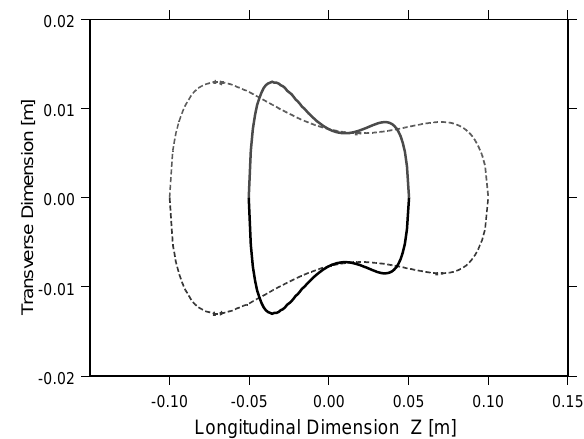
FIG. 10. The compressed beam bunch (solid line) inside a round metal pipe 4 cm in diameter, carrying the same space charge as the beam bunch of Fig. 1 (dashed line). To evaluate the importance of incorporating the ≠ 2 u (cid:3) ≠ z 2 correction term, a similar analysis was also done with beam pipe radii of 3 and 4 cm; see Fig. 9. For chamber radii of 2, 3, and 4 cm, the maximum deviations between the sub-3D solver and the slice algorithm were 4%, 3%, and 3%, respectively, with the largest errors for regions outside of the bunch. However, omitting the ≠ 2 u (cid:3) ≠ z 2 driving term causes deviations of 4%, 15%, and 21%, respectively, with the largest errors within the bunch. In a similar vein, a beam bunch with the same charge ( 10 2 11 C) and shape as that of Fig. 1, but longitudinally (cid:1) z (cid:2) shorter by a factor of 2, was evaluated; see Fig. 10. From Fig. 11, the sub-3D solver remains in good agree- ment when the driving term is included (left-hand plot), whereas the absence of the driving term (right-hand plot) shows a significant error of 20%.